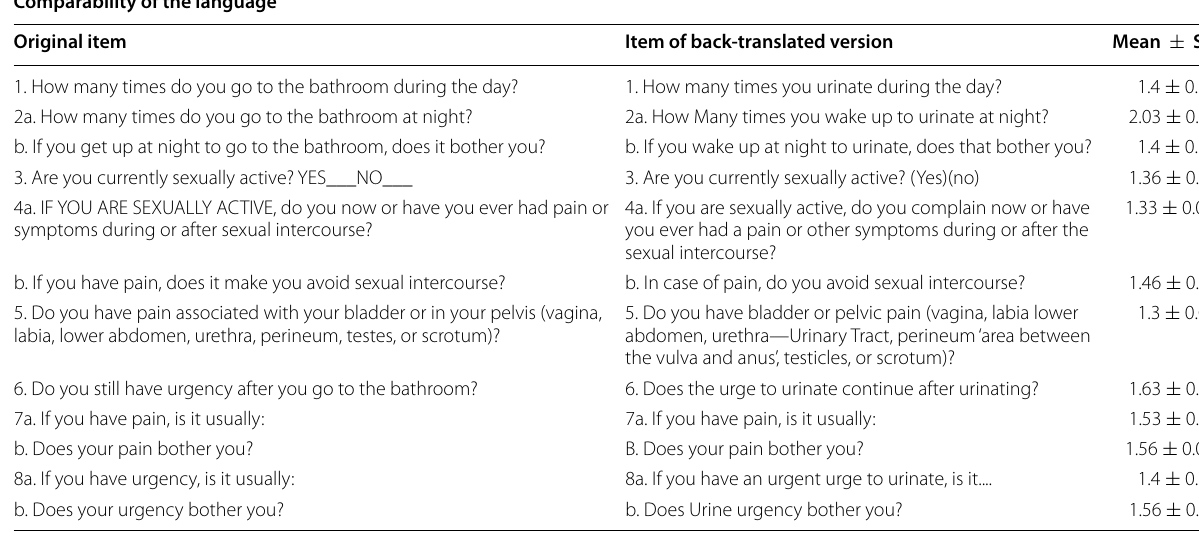
Table 1 Comparability of the language Comparability of the language